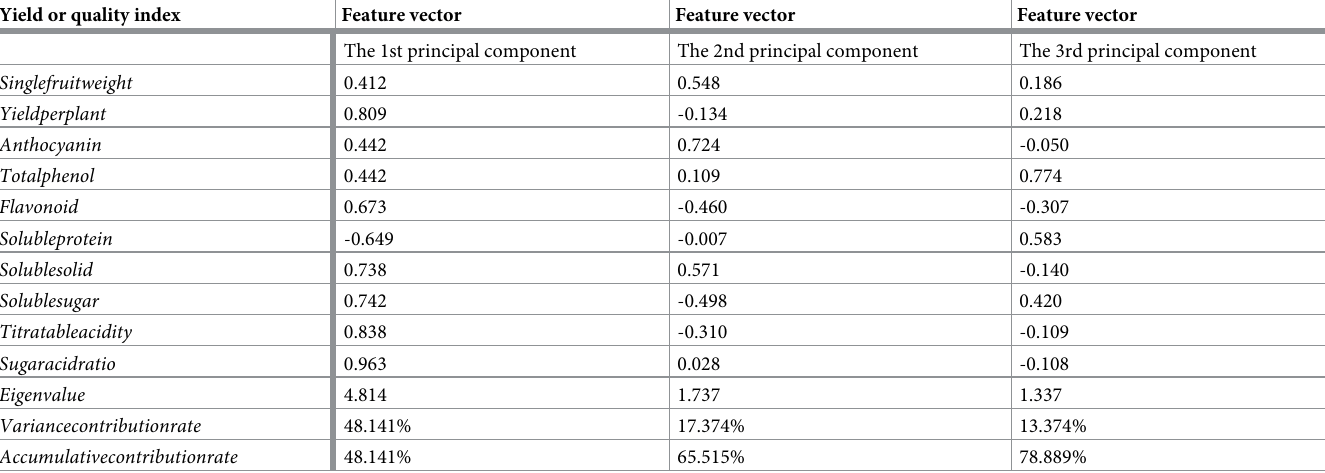
Table 5. Eigenvector load matrix of three principal